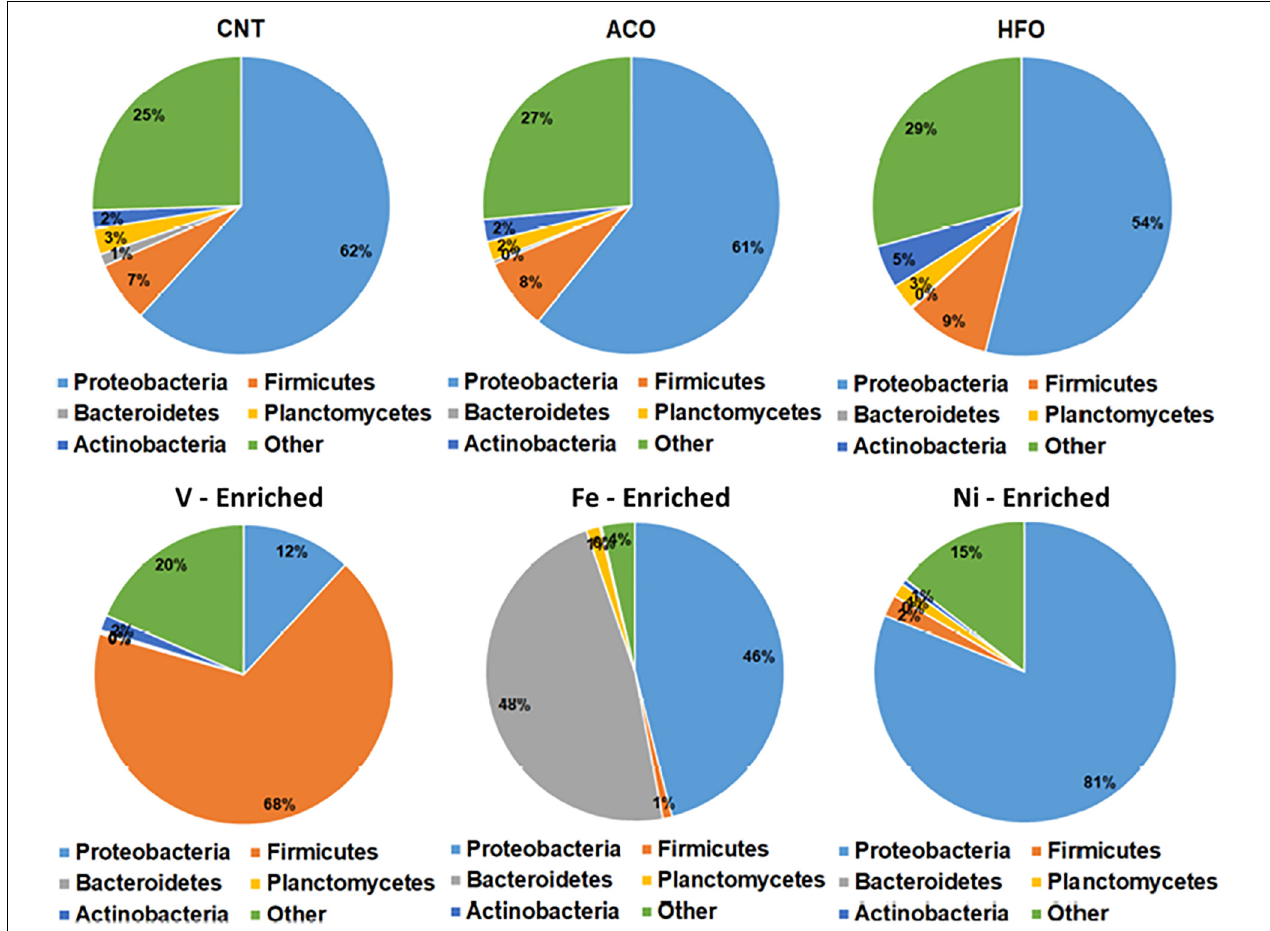
FIGURE 2 | Relative abundance of bacteria at the phylum level in the gut of barramundi with six different diets. Abbreviations: ACO, Australian crude oil; HFO, heavy fuel